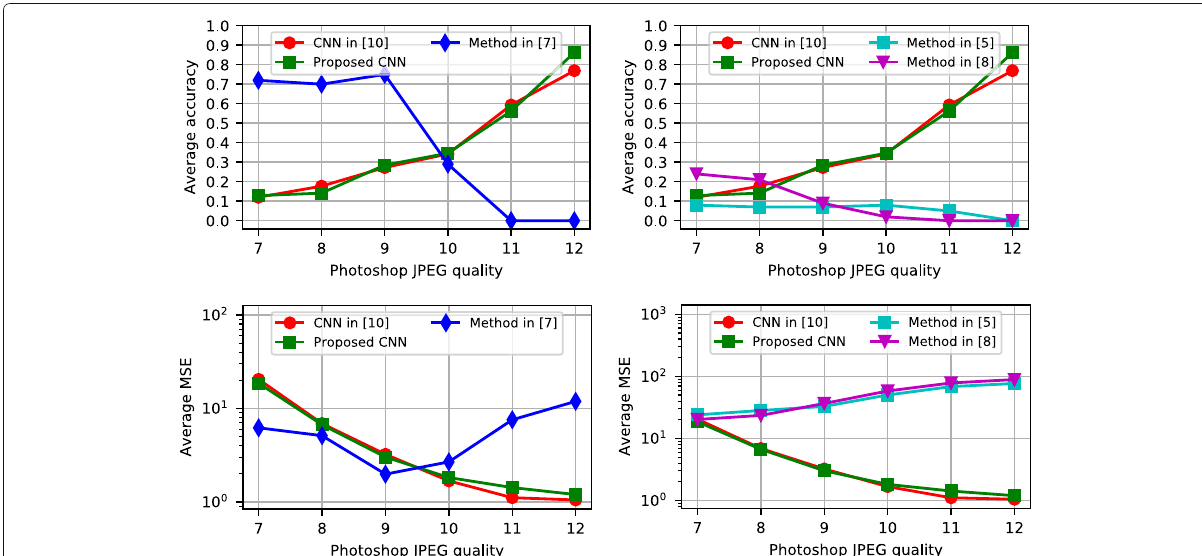
Fig. 11 Performance of the estimator when the first compression is performed with Photoshop for several PS qualities ( QF 2 = 90), in the aligned (first column) and non-aligned (second column) scenario